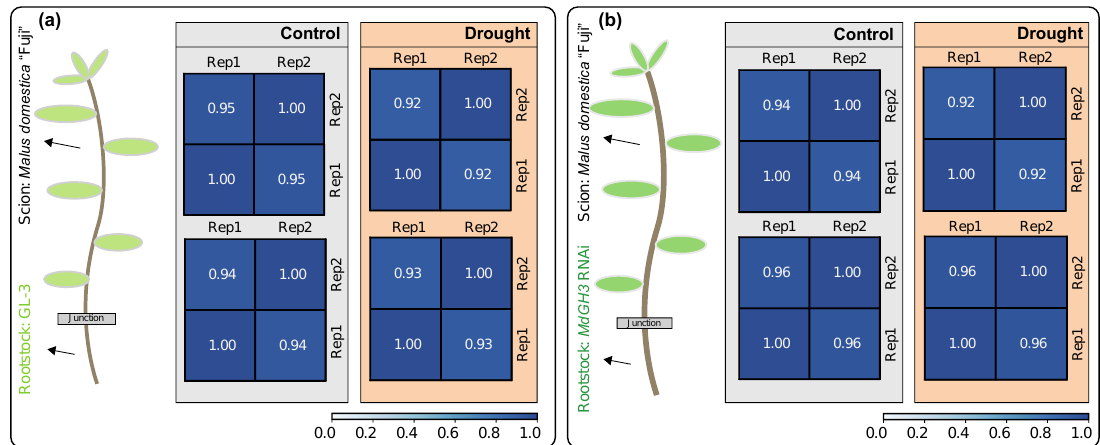
Figure 1. Experimental design of grafting and transcriptome sequencing. ( a ) Malus domestica “Fuji£ (scion) were grafted onto GL-3 plants (rootstock) under control and drought conditions. ( b ) Malus domestica “Fuji” (scion) were grafted on MdGH3 RNAi plants (rootstock) under control and drought conditions. The grey and orange areas show the transcriptome sequencing of the corresponding tissues in ( a , b ). The blue squares indicate the Pearson correlation of RNA-seq data. Two independent biological replicates per set were used for sequencing.